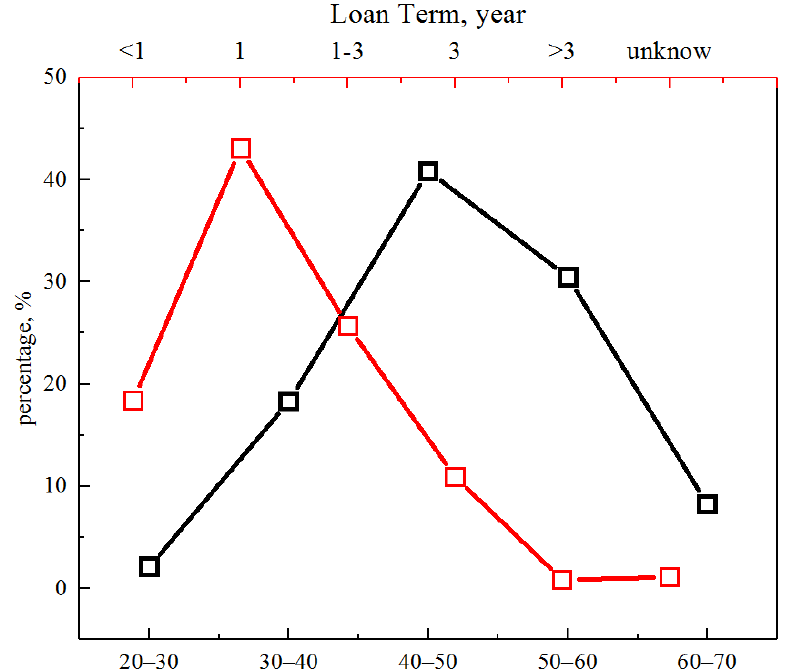
Figure 3. Age of the household head and the loan term of default farmland mortgage loans in Heilongjiang Province, starting time of loan, 2014–2020.